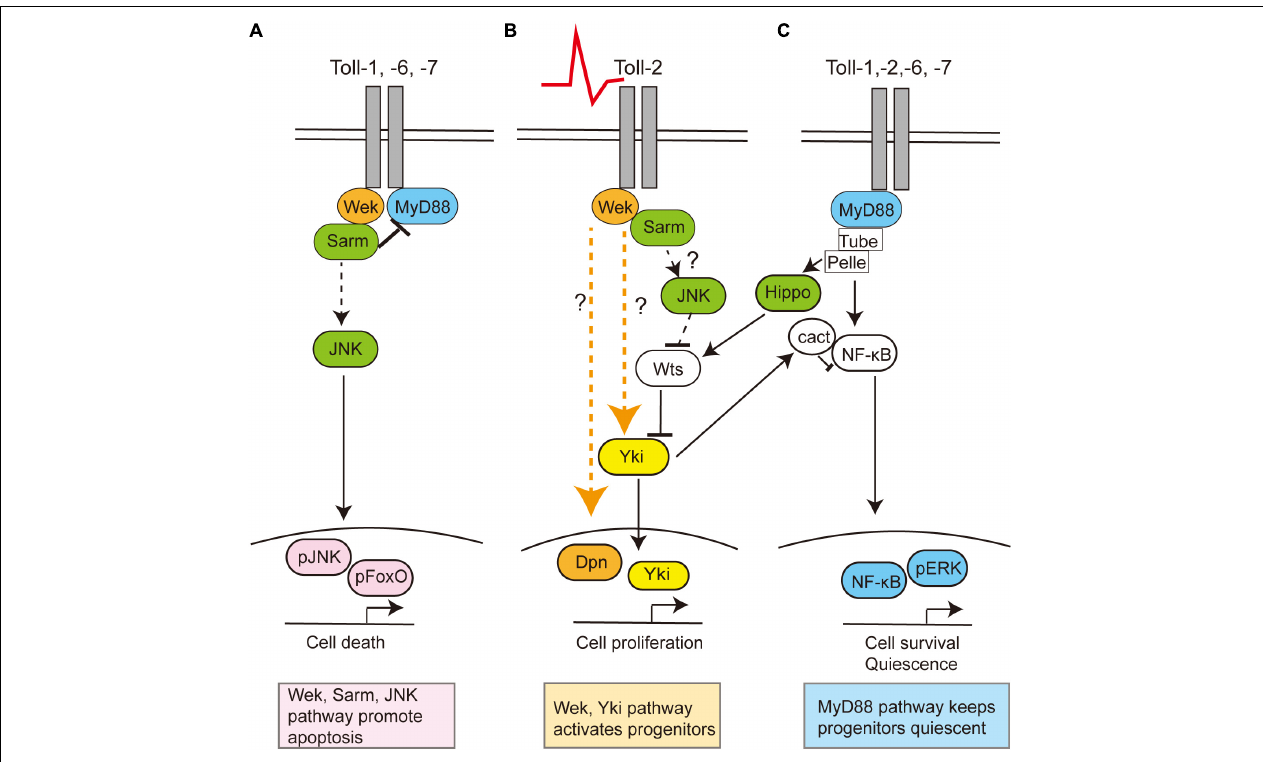
FIGURE 2 | Toll receptors can regulate cell survival, death, quiescence, or proliferation via alternative signaling pathways. Toll receptors share common functions, but they can also each elicit distinct cellular outcomes. This is a summary of data evidence on signaling by Toll-1, − 2, − 6, and − 7 in the central nervous system in embryonic, larval, and/or pupal development and Toll-2 in the adult brain. (A) During development, Toll receptors can promote cell apoptosis via Wek, Sarm, and JNK, (B) but in the adult brain, Toll-2 receptors can also function via Wek and Yki to promote cell proliferation. Question marks denote how or whether Wek signals remain unknown. (C) Toll receptors can promote cell survival via MyD88-NFkB signaling both throughout development and in the adult. Moreover, adult progenitor cells are normally kept quiescent via MyD88. In other contexts, the activation of Toll by gram-positive bacteria prevents proliferation by activating the Hippo pathway, thus inhibiting Yki, although whether this is also the case in the brain is